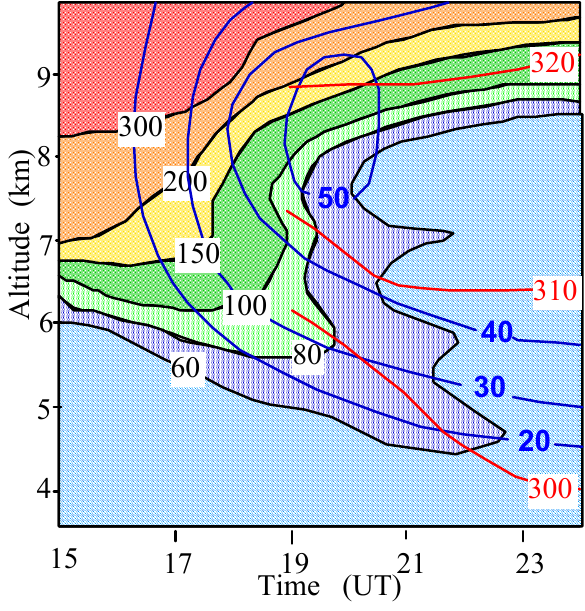
Fig. 4. Ozone mixing ratio (ppb) averaged over 10 minutes. Also drawn, three isentropes (300, 310 and 320 K) derived from the Ra- man lidar measurements and the observed wind